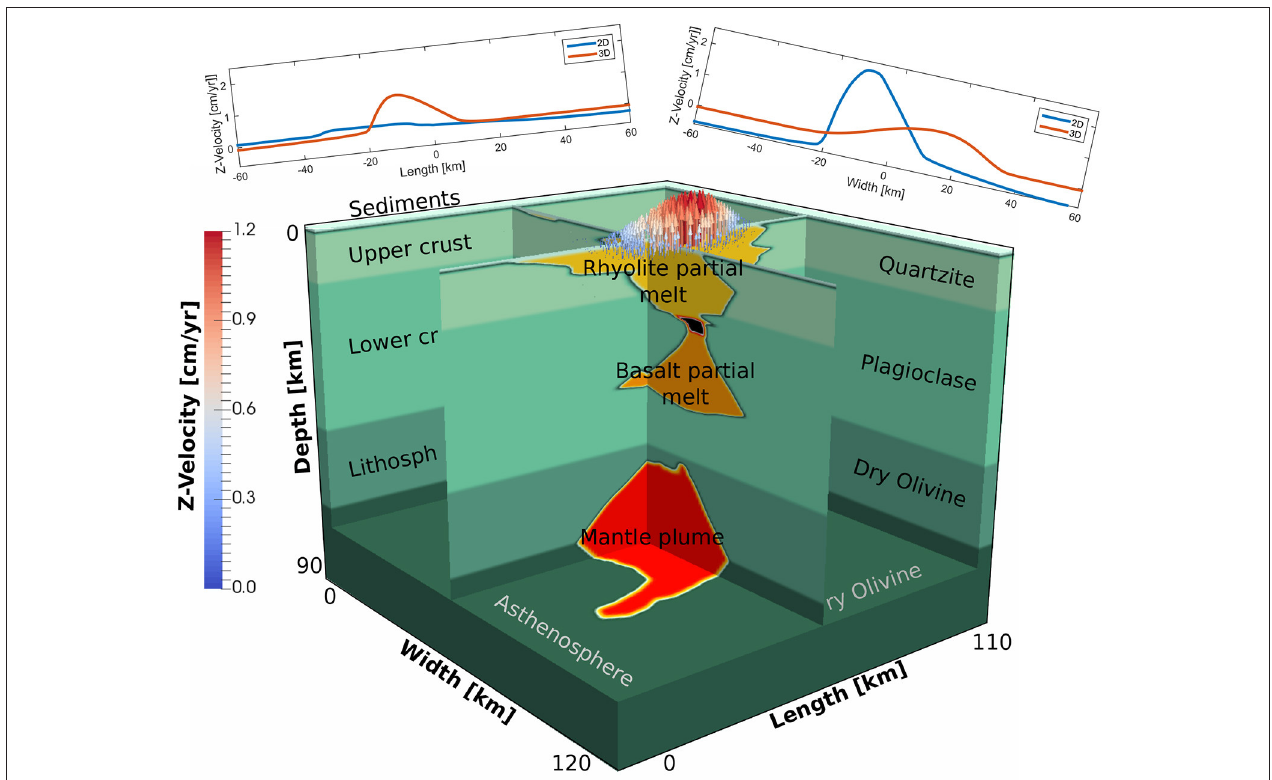
FIGURE 3 | Result of the comparison between 2D and 3D models. Two cross sections are shown with their respective surface velocity in 2D or 3D. The velocity profile is very distinct, suggesting that 3D effects are important to take into